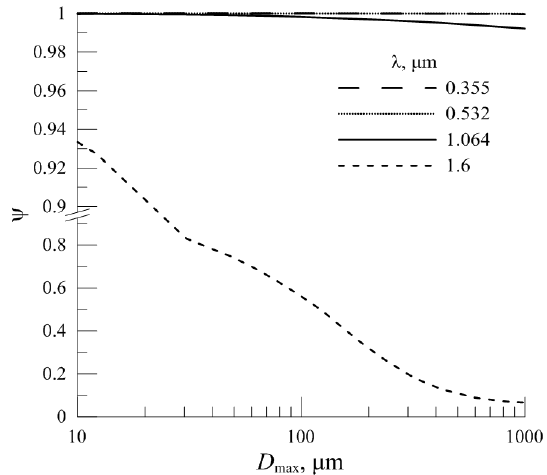
on (cid:4) for the arbitrary max formed